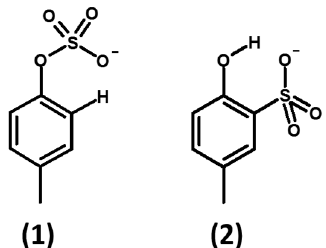
Figure 2. Structure of reaction products of activated sulfuric acid at the oxygen atom (sulfation, 1 ), at a ring carbon atom (sulfonation, 2 ).